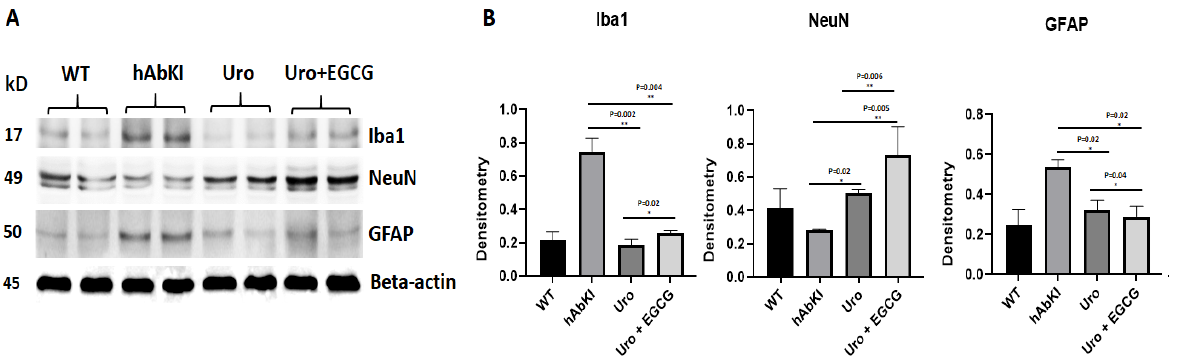
Figure 7. Immunoblotting analysis of Inflammatory and neuronal proteins NeuN, microglial marker Iba and astrocytic marker GFAP . ( A ) Representative immunoblots for microglia Iba, astro- cytes GFAP and neuronal marker NeuN in hAbKI mice and treated hAbKI. ( B ) Significantly increased levels of the neuronal marker NeuN and decreased levels of microglial marker Iba and astrocytic marker GFAP in -seven-month-old hAbKI mice treated with Urolithin A and EGCG.